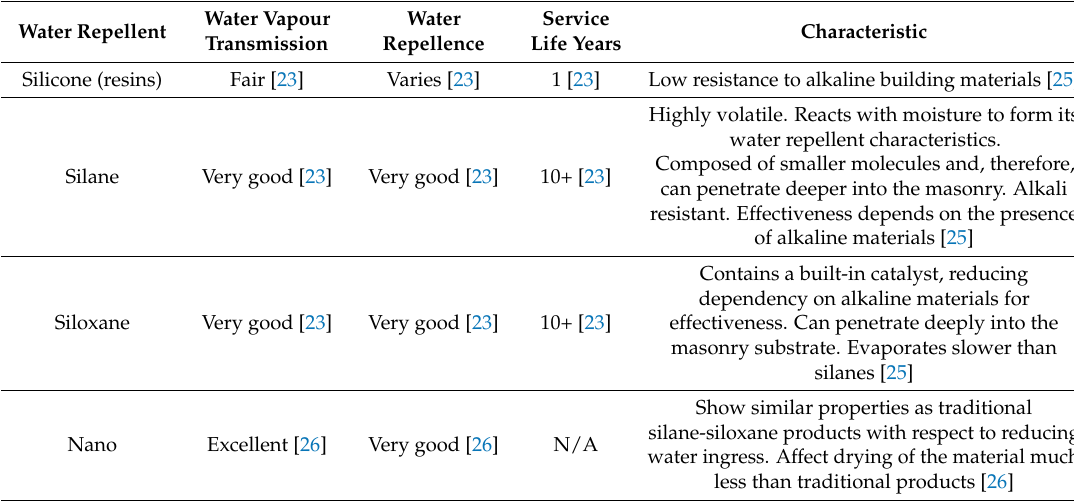
Table 1. Types of water-repellent